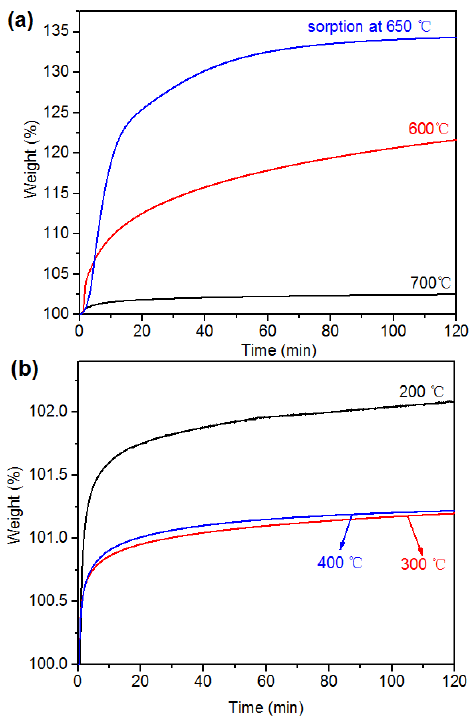
Figure 6. ( a ) CO 2 sorption performance of Li 4 SiO 4 -(EX-VMT)-4 sorbent evaluated at different sorption temperatures of 600, 650, and 700 ◦ C, and ( b ) the influence of sorption temperature on the CO 2 capture performance of Mg-Al-CO 3 LDH synthesized from the vermiculite leaching